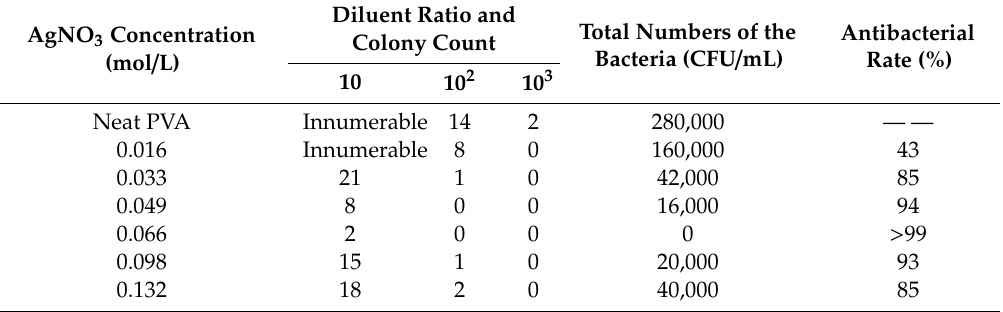
Table 2. Antibacterial test results by adsorption method for Ag / PVA CNFs prepared with di ff erent concentrations of AgNO 3 against S. aureus